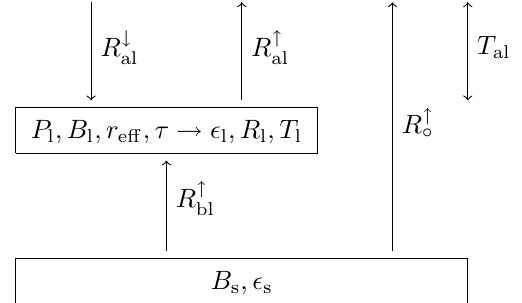
Figure 3. Schematic showing the atmospheric interactions simu- lated in the radiative transfer forward